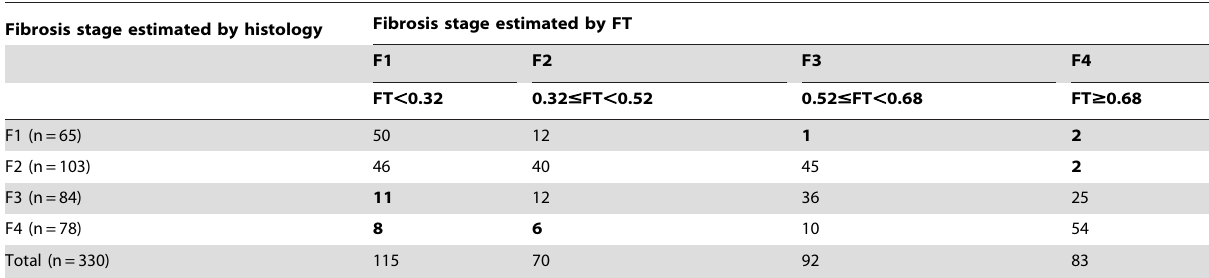
Fibrosis stage estimated by histology